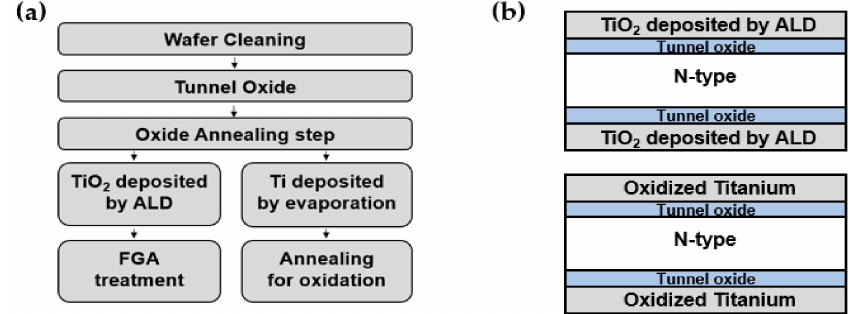
Figure 2. ( a ) Process flow and ( b ) schematic structures for the fabrication of symmetrical lifetime samples to eValuate lifetime and implied V oc